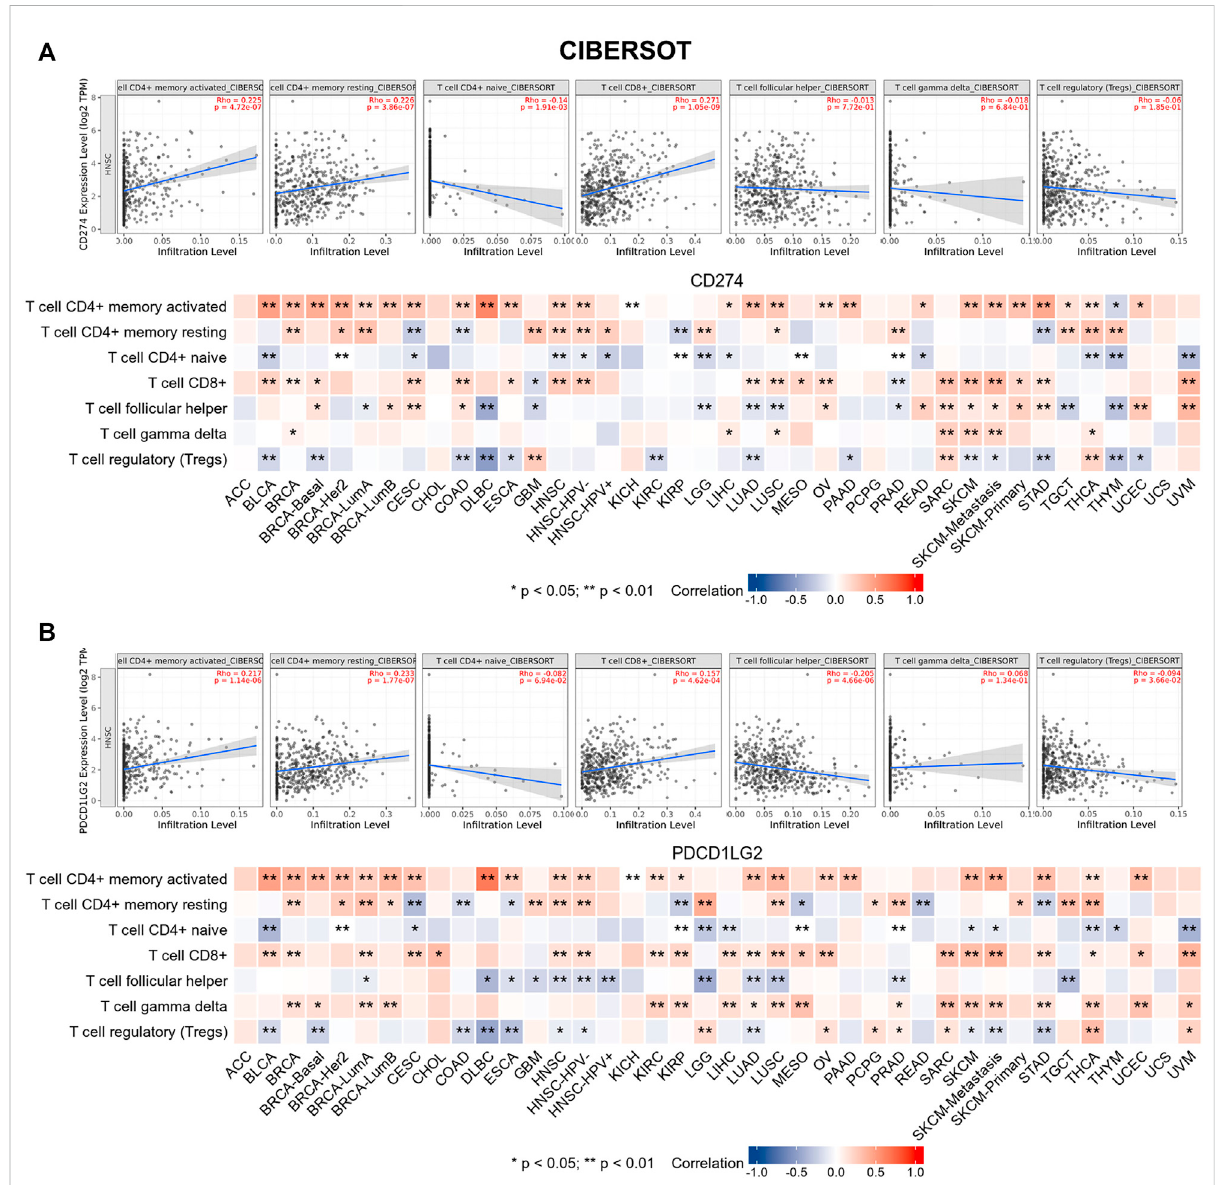
FIGURE 6 CIBERSORT predicted the relationship between (A) CD274 and (B) PDCD1LG2 expression and seven T-cell subtypes. Representative results in HNSC are shown at the